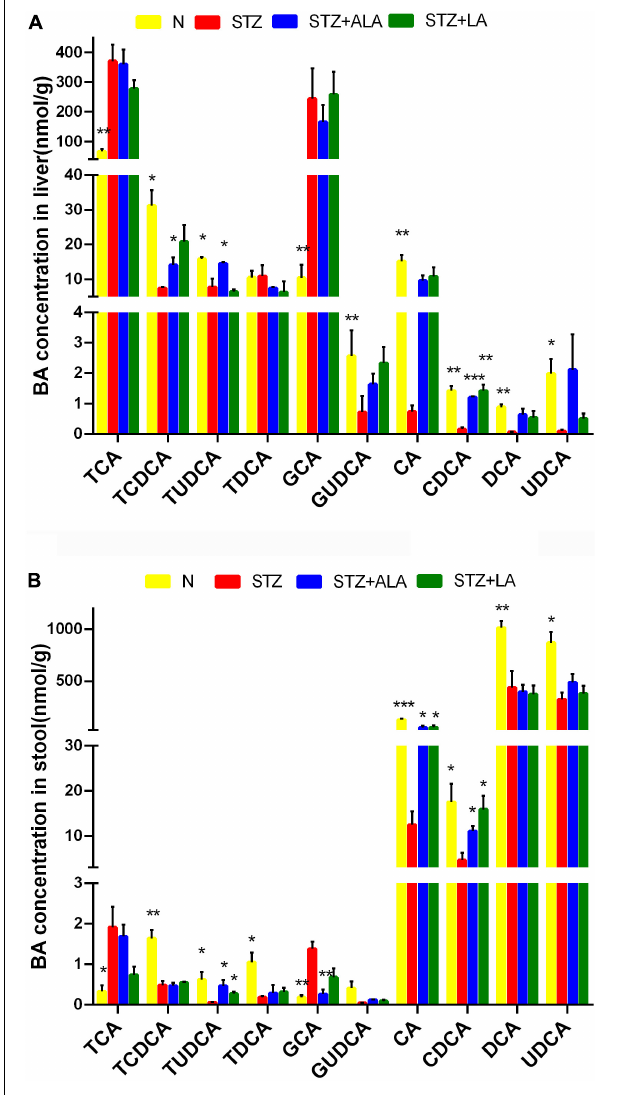
FIGURE 7 | The concentrations of individual BAs in liver tissue (A) and stool (B) . Results were shown as mean ± SEM ( n = 5) vs. the STZ-treated